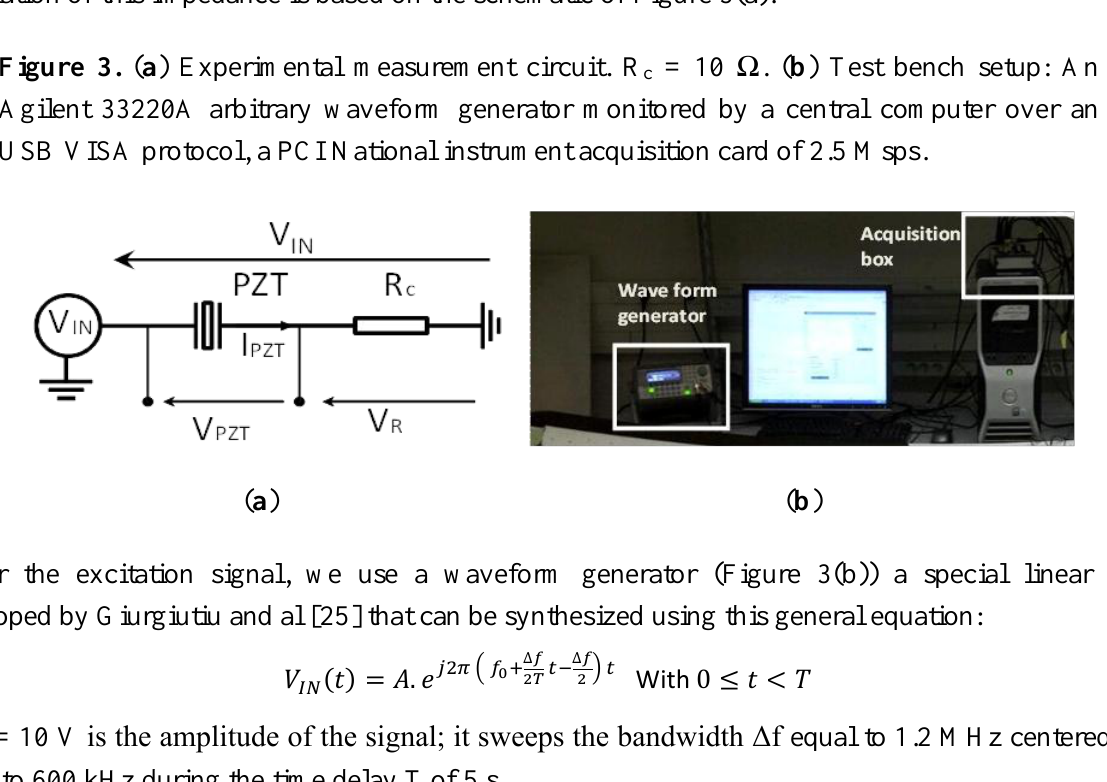
= 10 Ω. ( b ) Test bench setup: An c